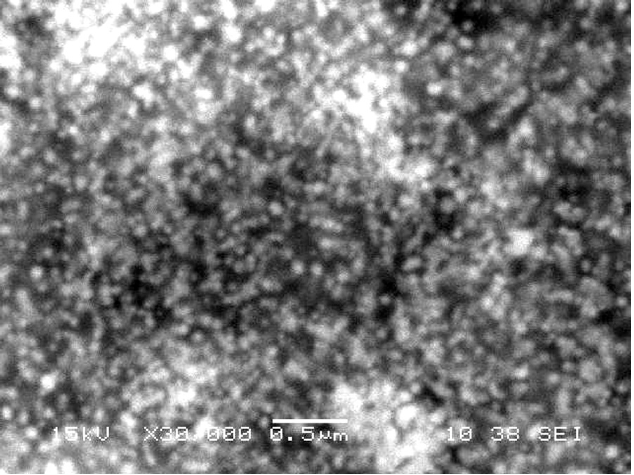
Figure 3. A scanning electron microscope image of gold nanoparticles phytofabricated by Ricinus communis leaf extract. The AuNPs are shown as round, crystalline, uniform aggregates.